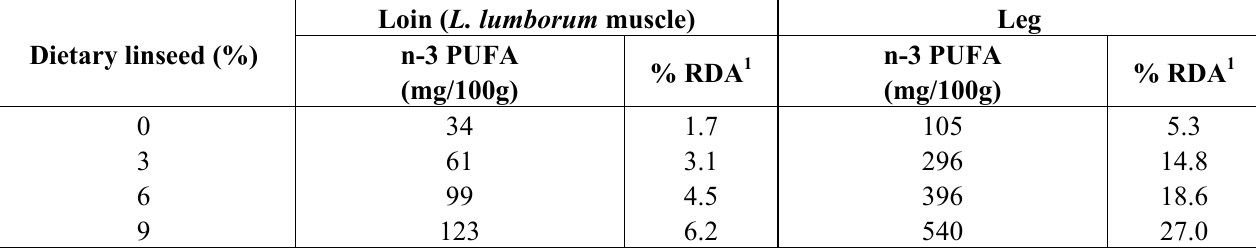
Table 1. Influence of dietary linseed and type of muscle on total n-3 PUFA content of rabbit meat (mg/100g meat) and estimation of % recommended daily allowance (RDA) for n-3 PUFA based on a serving size of 100 g of